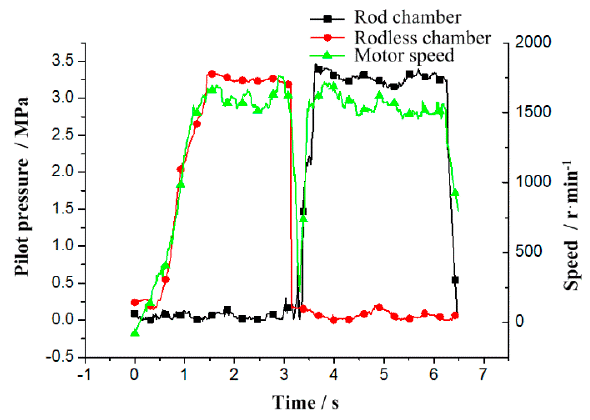
Figure 15. Pilot pressure and motor speed curves of the PFS based on variable speed control.